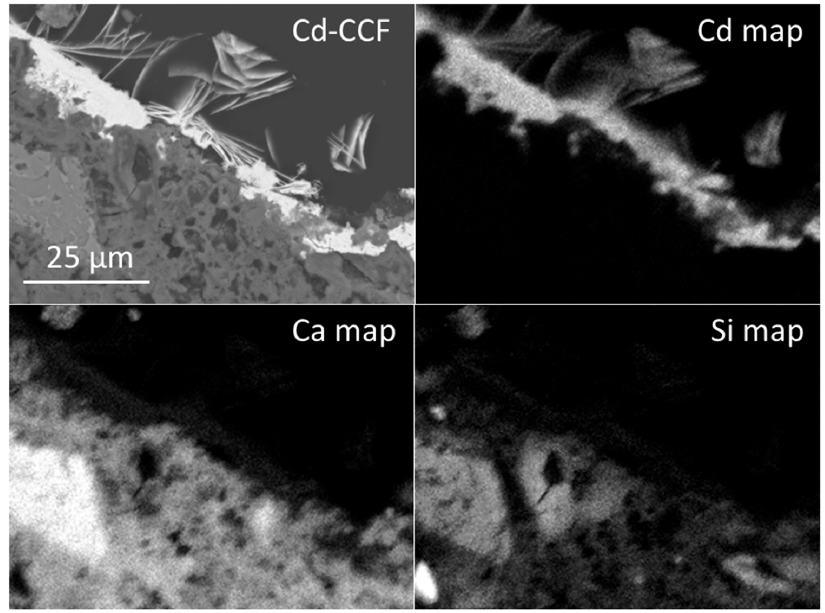
Figure 7. Back-scattered electron micrograph of cross section of cadmium-laden CCF particle and corresponding EDX maps for cadmium, calcium and silicon. All images are of the same sample area.